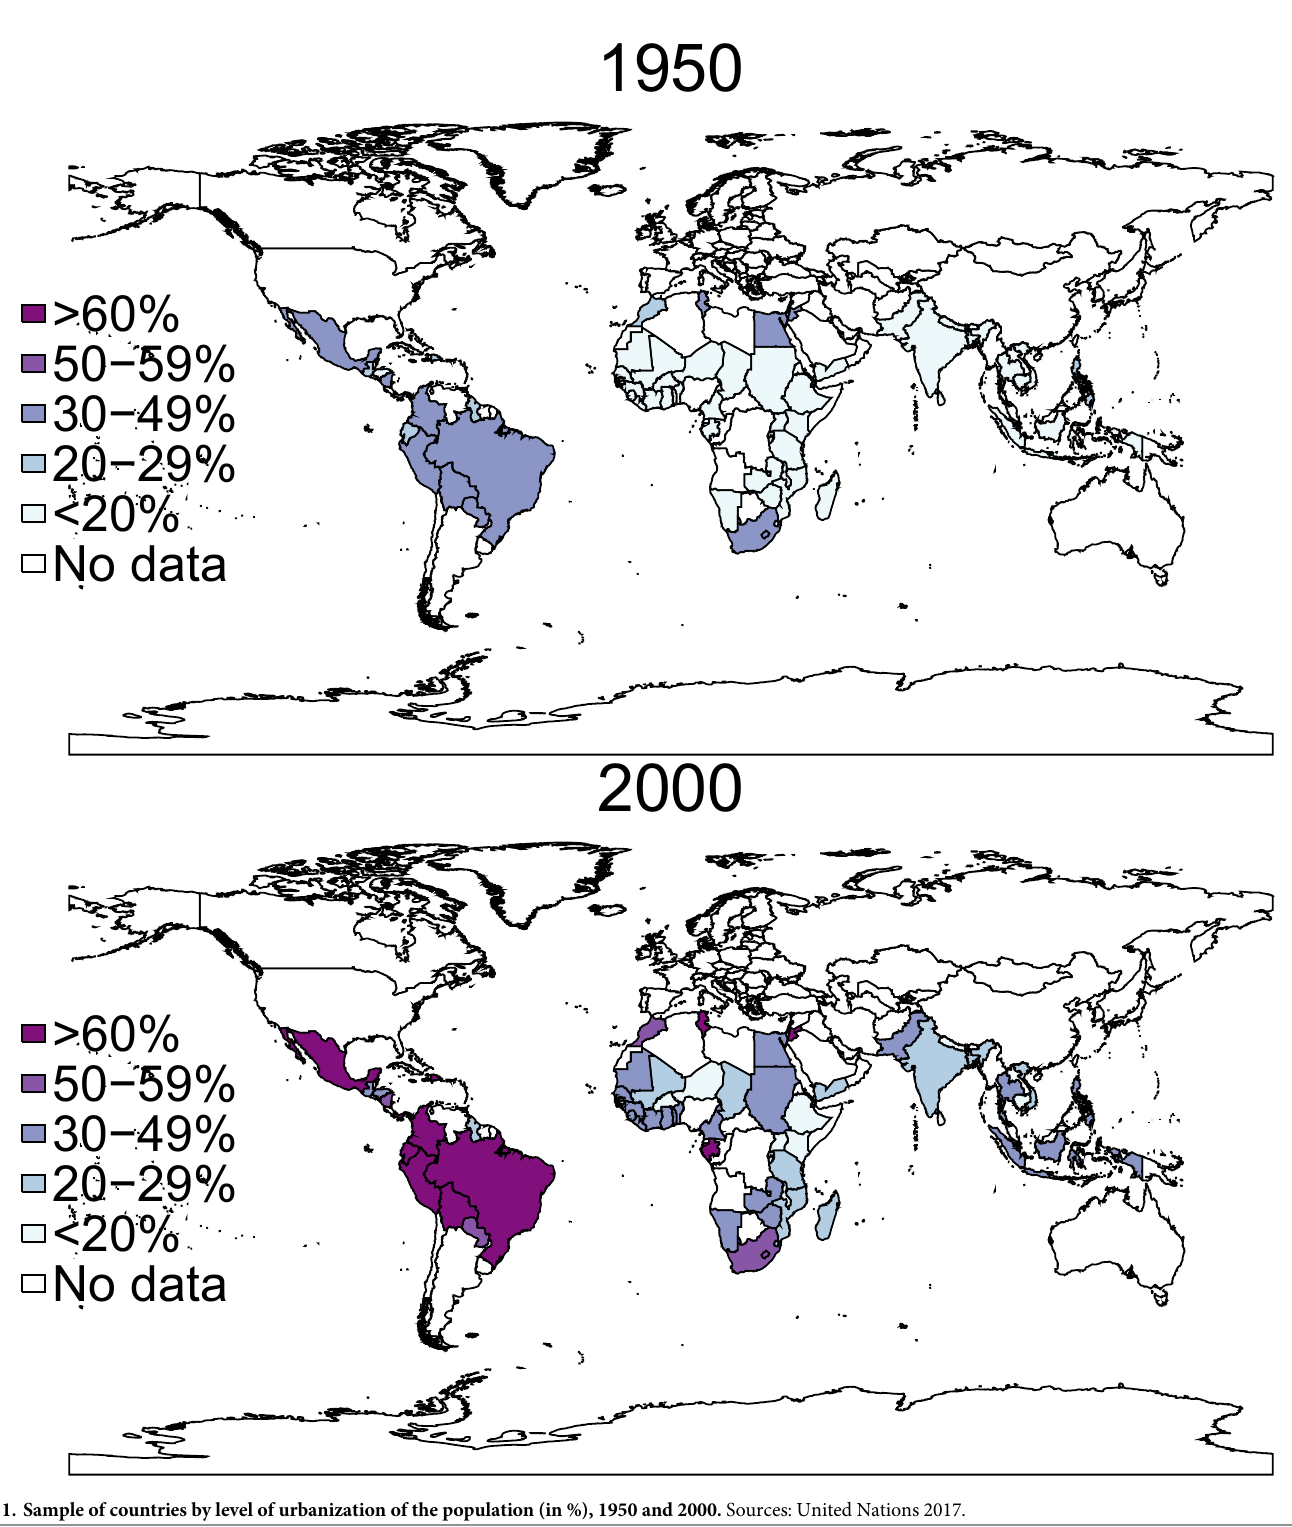
Fig 1. Sample of countries by level of urbanization of the population (in %), 1950 and 2000. Sources: United Nations 2017.